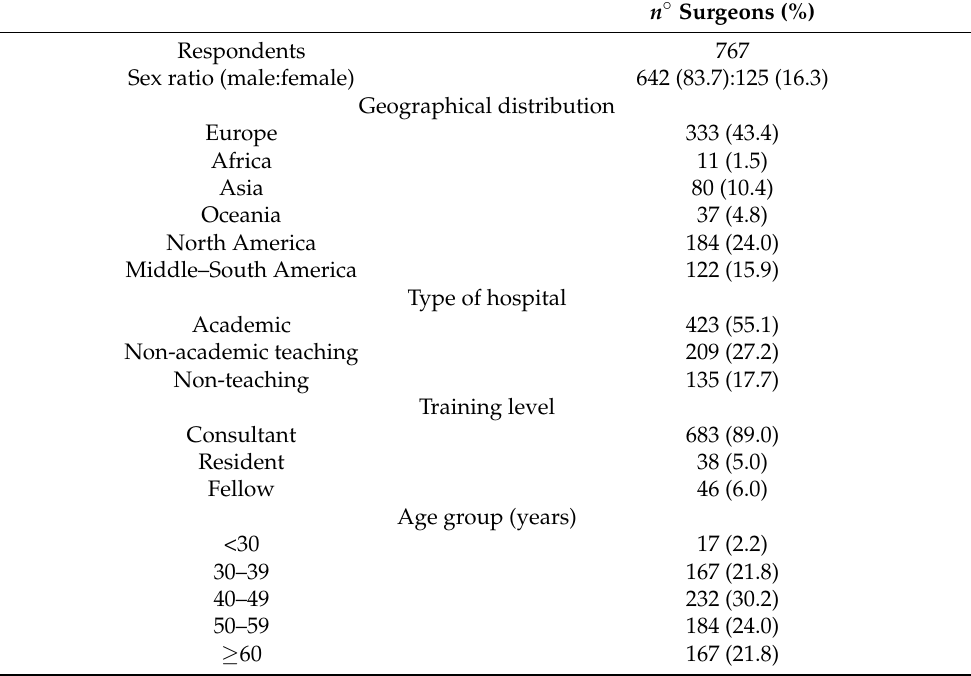
Table 1. Baseline characteristics of participating